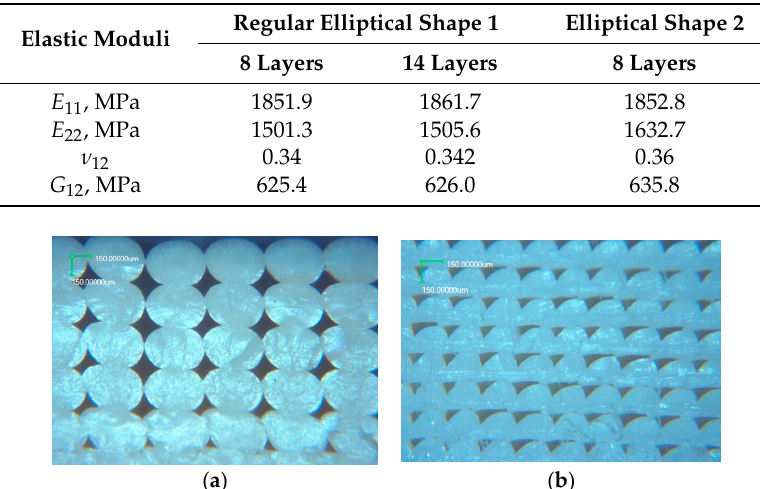
Figure 7. Mesostructure of the printed part ( a ) higher layer thickness, 0.317 mm; ( b ) lower layer thickness, 0.181 mm.